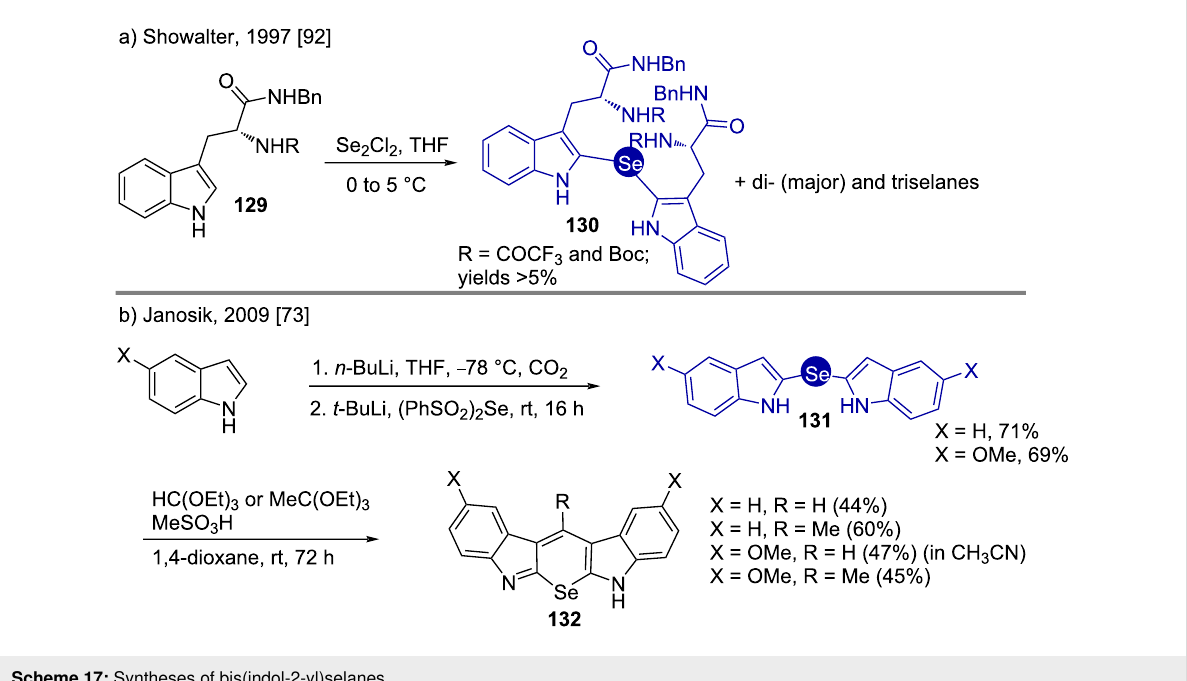
Scheme 17: Syntheses of